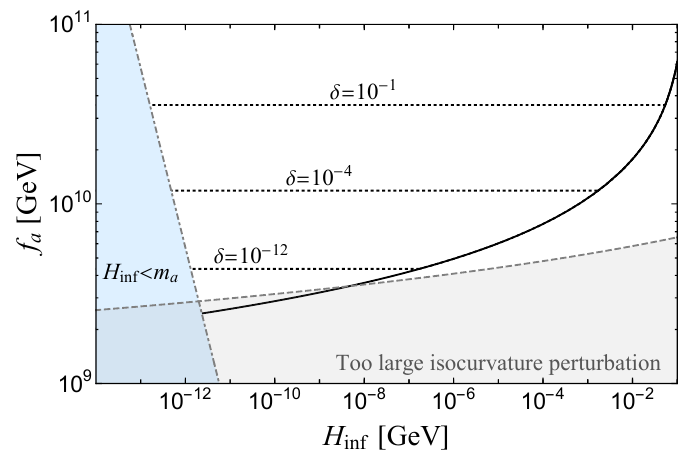
Figure 3 . f a as a function of H inf for (cid:14) = 0 ; 10 (cid:0) 12 ; 10 (cid:0) 4 ; 10 (cid:0) 1 , where the QCD axion with the initial misalignment (2.12) explains DM. The lower gray region is excluded due to too large isocurvature perturbation. In the left blue region, m a ( T inf ) > H inf , and our analysis cannot be